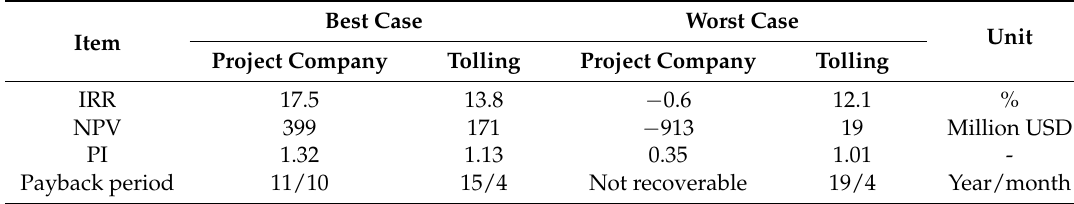
Table 12. Project B project company vs. tolling model economic evaluation.